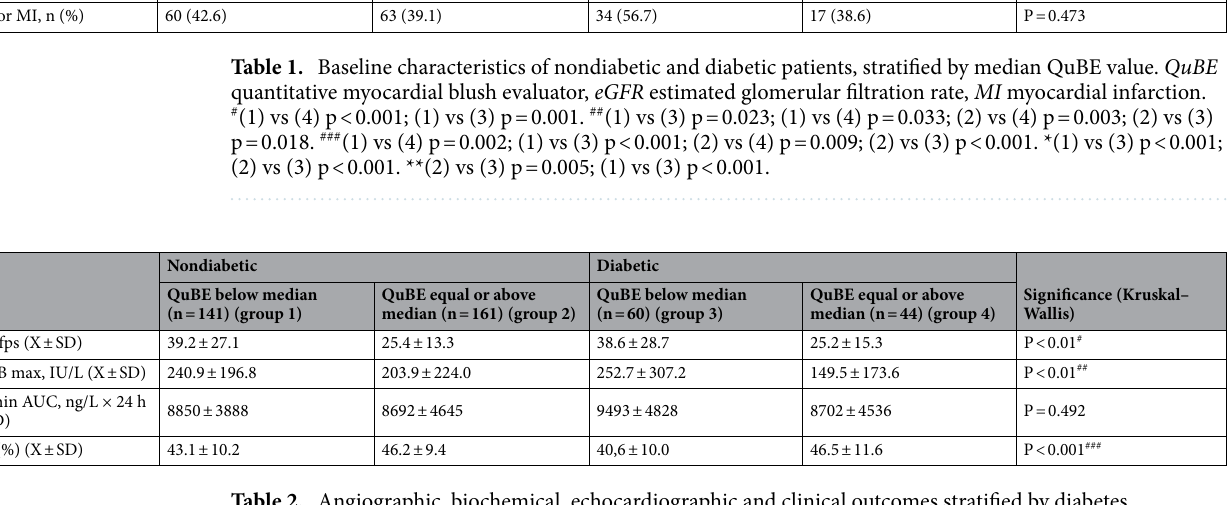
Table 2. Angiographic, biochemical, echocardiographic and clinical outcomes stratified by diabetes and QuBE. AUC area under the curve, QuBE quantitative myocardial blush evaluator, cTFC corrected